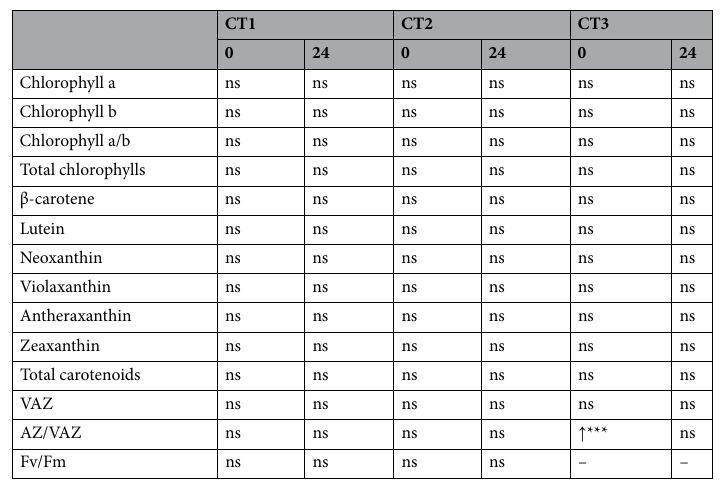
Table 1. The results of contrast analysis of selected biochemical and physiological parameters in sweet cherry leaves exposed to one (CT1), two (CT2) or three (CT3) overnight chillings, sampled at time 0 or time 24 and compared with control in Experiment I. *Statistically significant differences at P < 0.05; ***statistically significant differences at P < 0.001; ns, not significant; ↑ = increase in chilled leaves; ↓ = decrease in chilled leaves; –, not monitored; VAZ, xanthophyll cycle pigments; AZ/VAZ, deepoxidation state of xanthophyll cycle pool; Fv/Fm, maximum quantum yield of PS